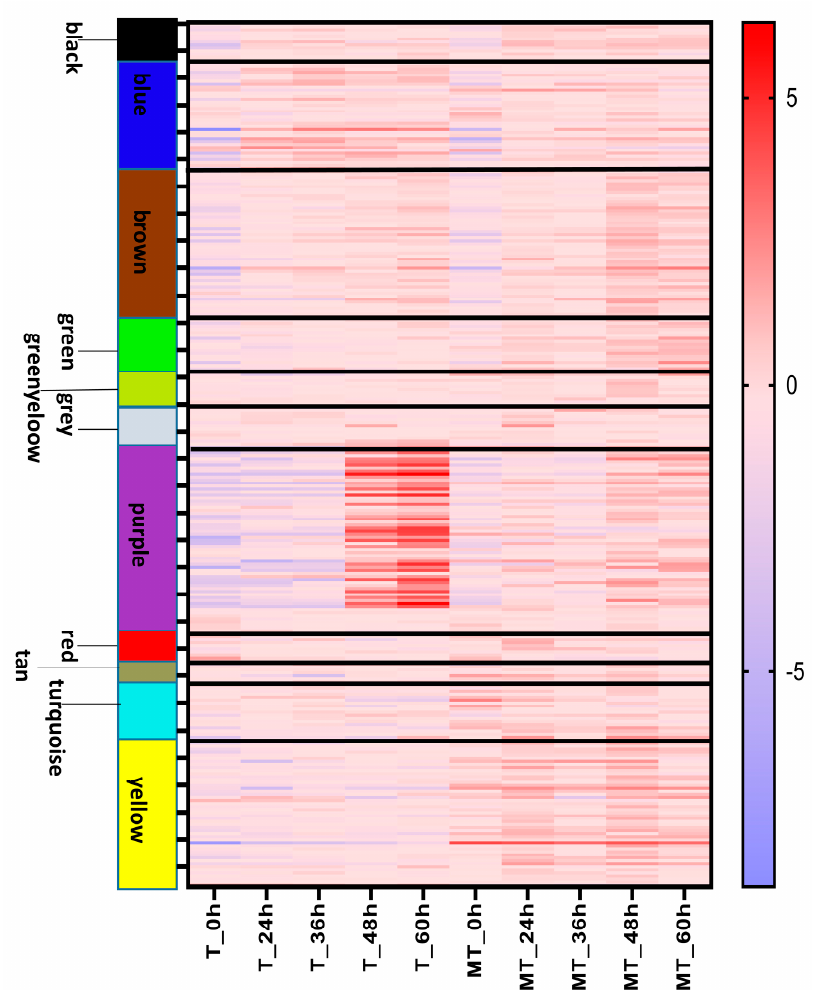
Figure 5. Expression of the U. esculenta secretome. For each co-expression module, the heat map shows the expression of genes encoding putative secreted proteins. Log2 expression levels are visualized relative to the mean expression across all stages of T- and MT-type U. esculenta .